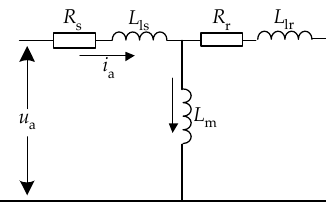
Figure 3. Single-phase AC equivalent circuit, where u a is the stator voltage of phase-A respectively, L ls is the stator leakage inductance, and L lr is the rotor leakage inductance.